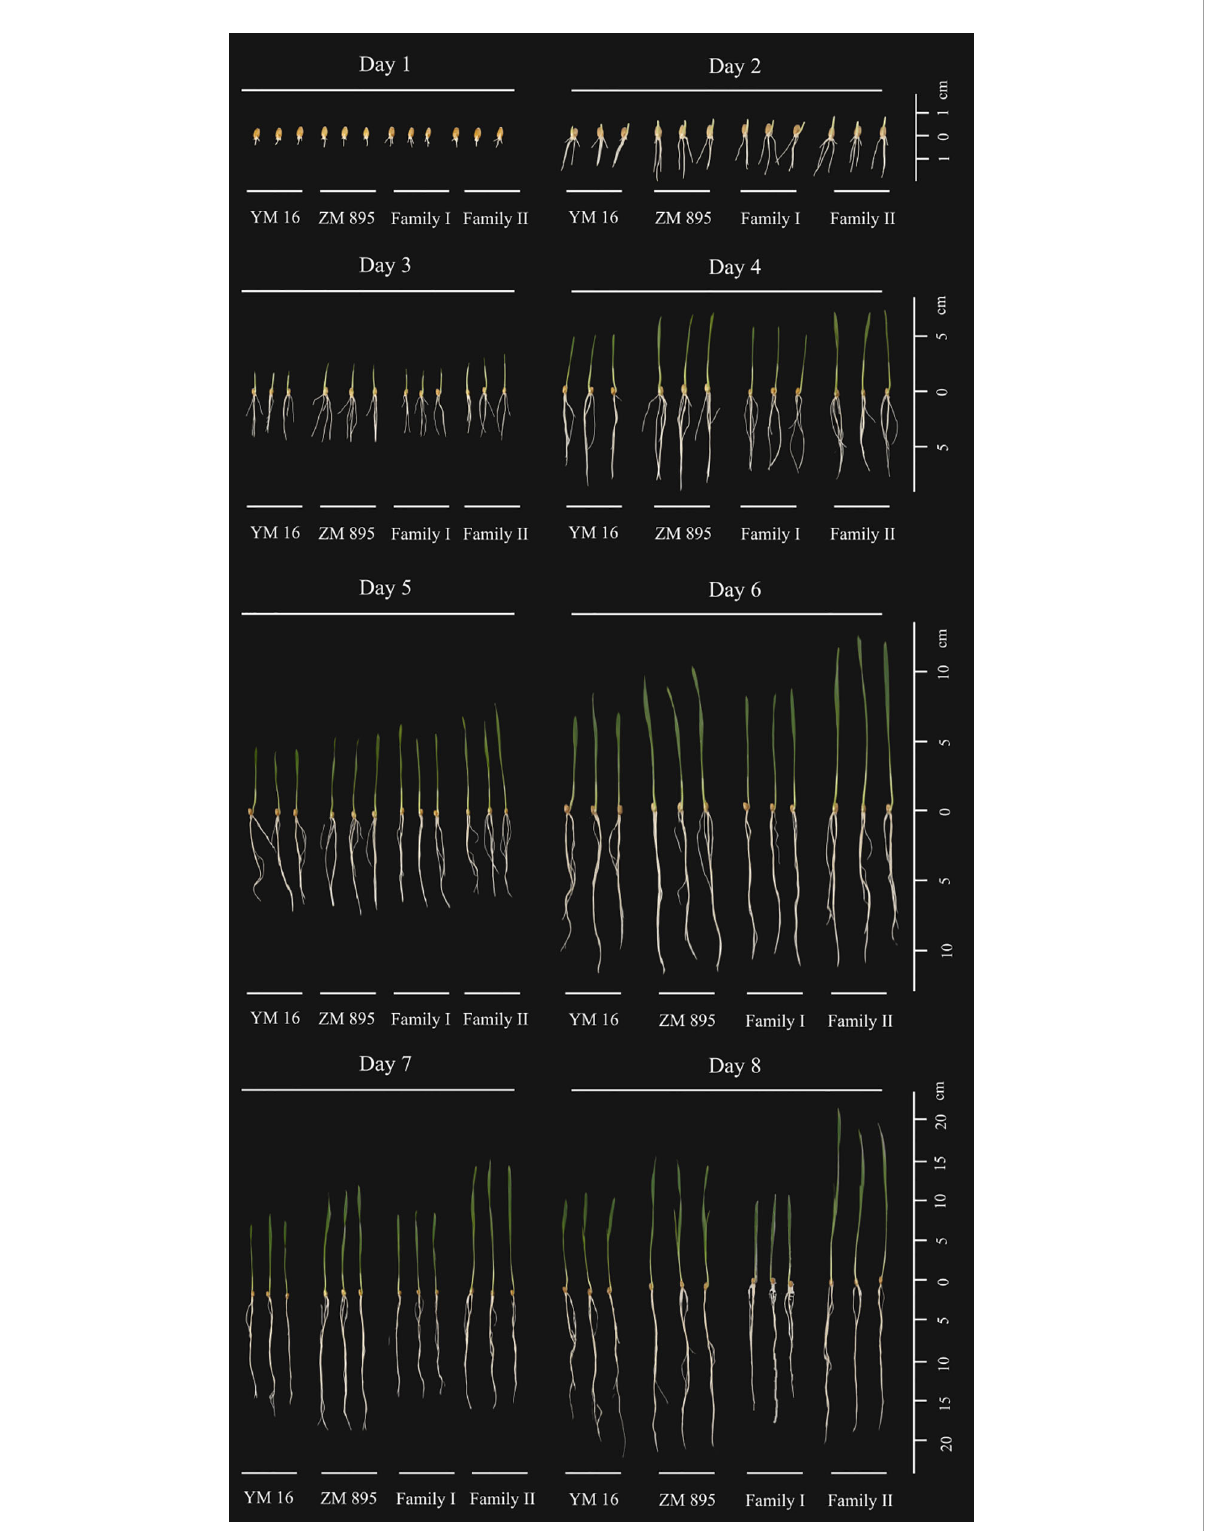
FIGURE 1 The growth of DH lines using the paper roll method.Three seeds are shown in each group, YM 16: Yangmai 16, ZM895: Zhongmai 895, Family I represent the lines of low seed vigor, Family II represent the lines of high seed vigor, Day1-Day 8 refer to days after